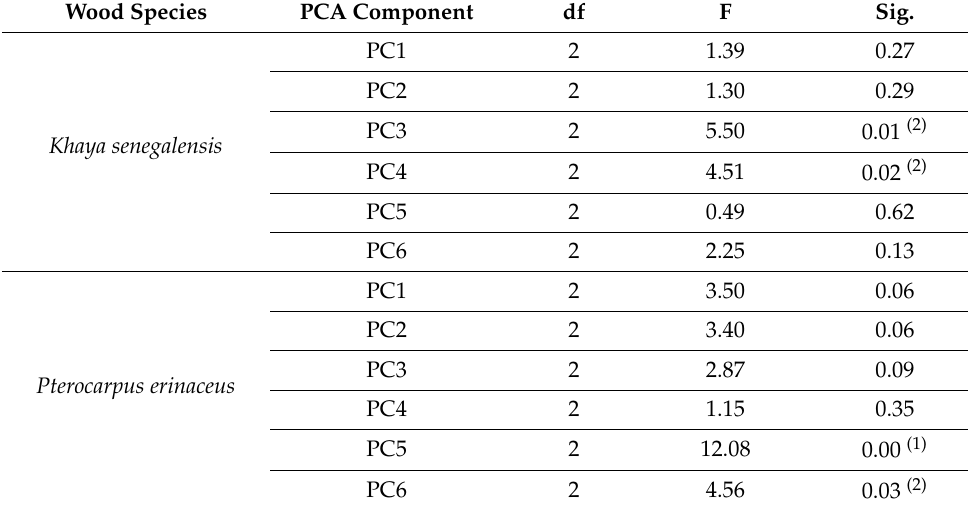
(1) significant differences at p < 0.01; and (2) significant differences at p < 0.05.